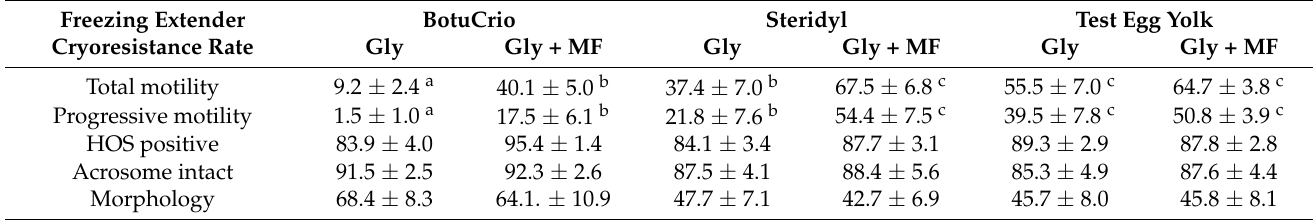
Table 4. Calculated cryoresistance ratio for giraffe sperm motility, progressive motility, membrane function, acrosome, and morphology. Data are pooled over n = 7 males ± SEM. Columns which differ in superscript indicate significant differences between treatments ( p <